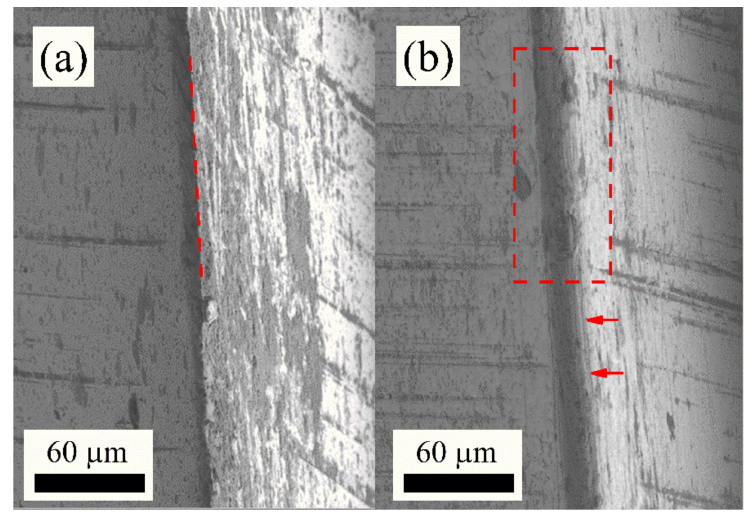
Figure 5. The sharp blades ( a ) made of 154CM stainless steel degraded into a round surface with abrasive grooves ( b ) after the cutting test.